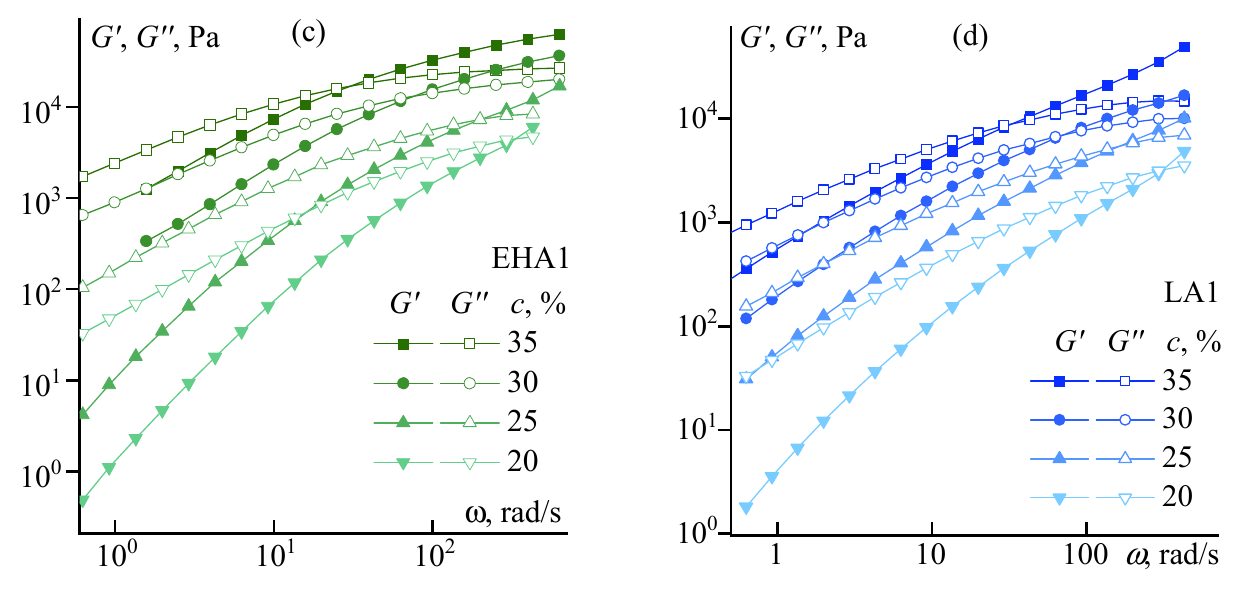
Figure A1. Frequency dependences for concentrated solutions of PAN high molecular weight copolymers (AlkA1) at 70 °C, where: ( a )—methyl acrylate, ( b )—butyl acrylate, ( c )—2-ethylhexyl acrylate, ( d )—lauryl acrylate.